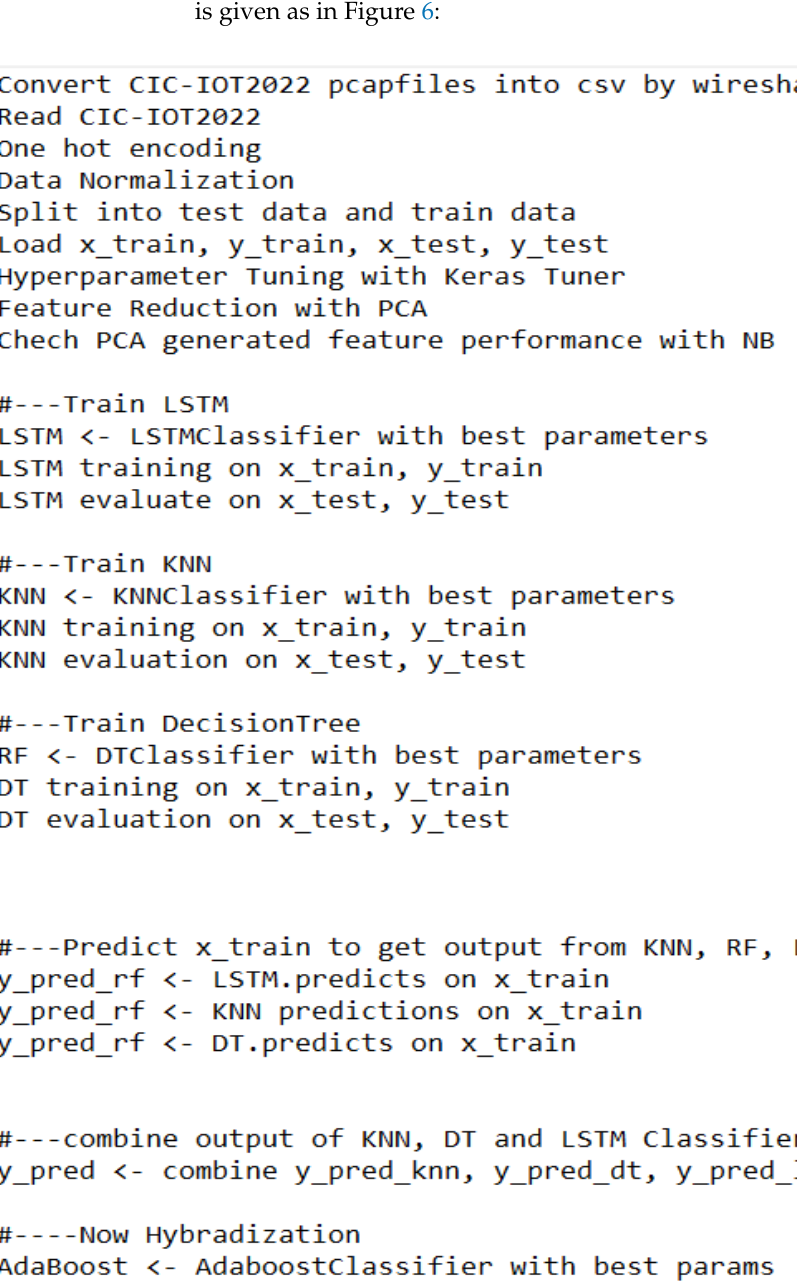
Figure 6. Pseudo-code. Figure 6.